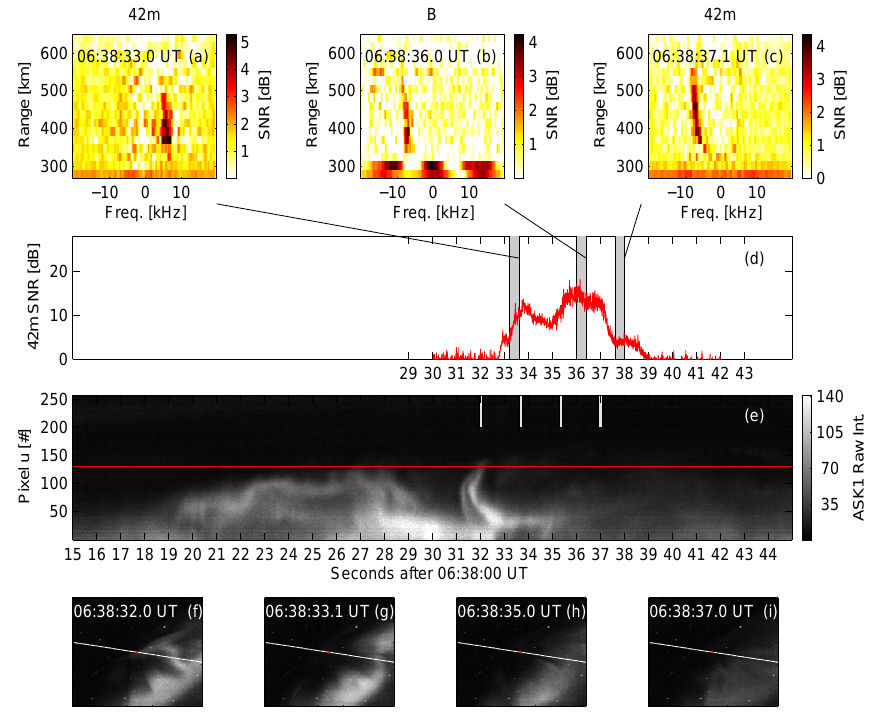
Figure 3. Time history for the NEIAL event observed on 17 December 2012. Panel (a) – (c) show power spectra (400ms time integration and 22.5km range gates) obtained with antenna 42m, B, and 42m again for the time periods highlighted in panel (d) and centered at 06:38:33.4, 06:38:36.2, and 06:38:37.8UT. Measurements below 300km are dominated by ground clutter. Panel (d) shows the signal-to-noise ratio (SNR) of unprocessed and un-decoded data observed with the 42m antenna. Panel (e) shows a stackplot of intensity as observed with ASK1 along the white line in the snapshots presented in panel (f) – (i) , the timing of which is indicated by the white tick marks. The solid red line, panel (e) , and red markers, panels (f) – (i) , indicate magnetic